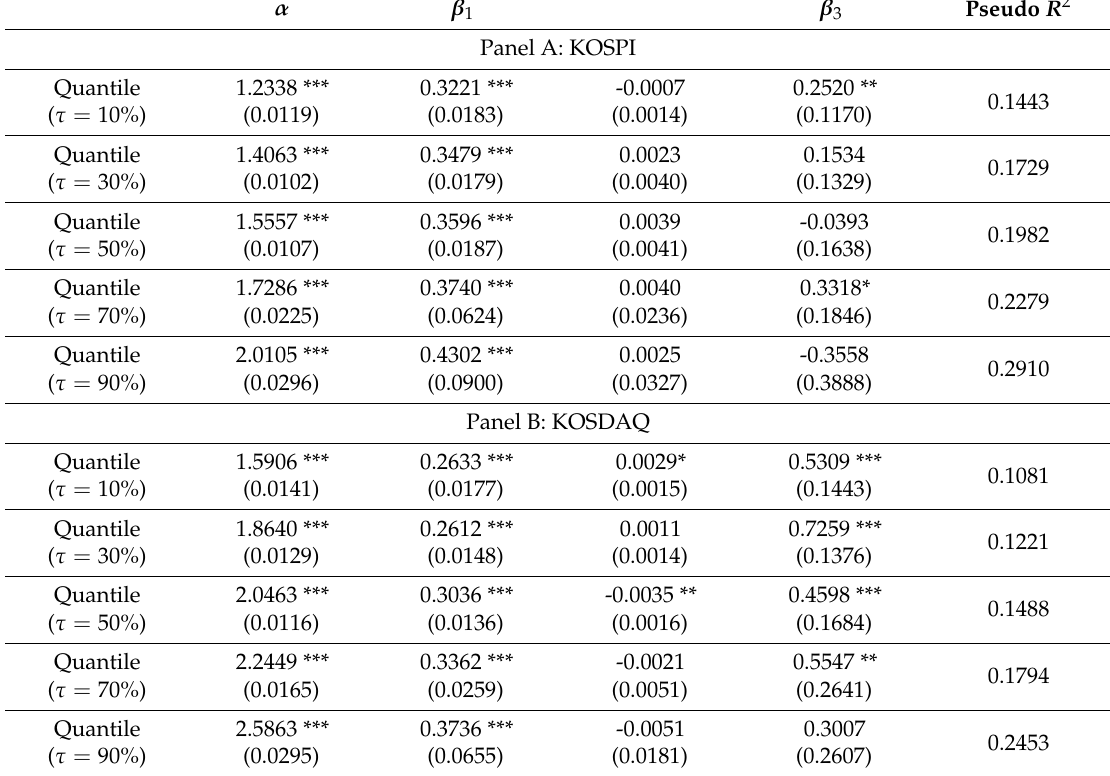
Table 9. Estimates of herding behavior incorporating investor